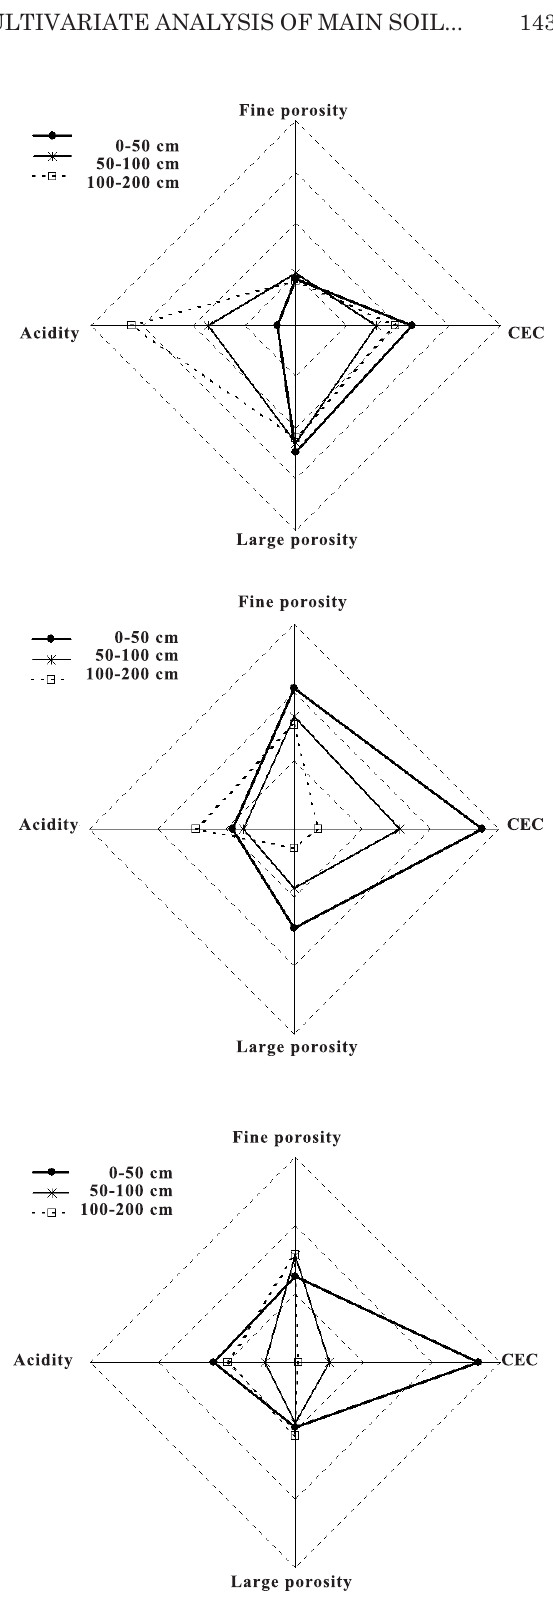
Figure 3. Factor scores in the soil layers 0–50, 50– 100 and 100–200 cm, in non-irrigated soil (3a), irrigated with sodic tap water (3b) and irrigated with wastewater (3c). “Fine porosity”: factor 1; “Large porosity”: factor 2; “Soil CEC”: factor 3; “Acidity”: factor